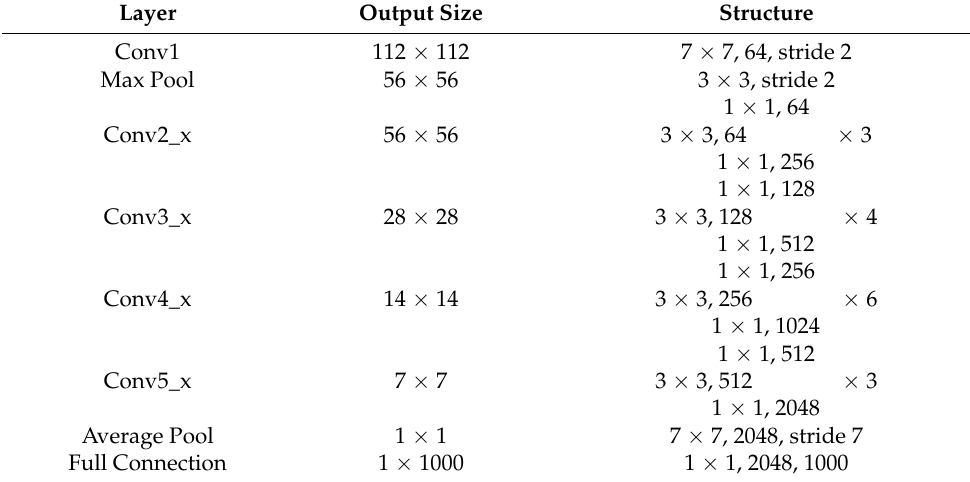
Table 1. ResNet50 network